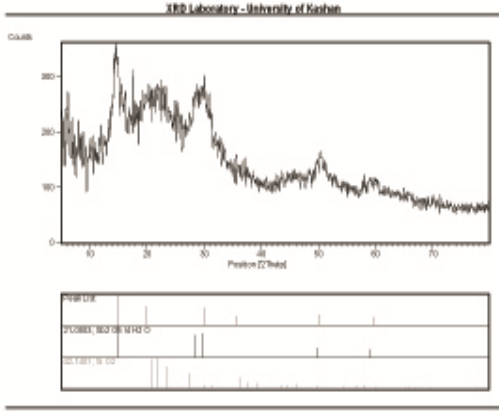
Fig. 2. The XRD pattern of nano SbCl /SiO 5 2 To obtain a visual image of the nano- /SiO , scanning electron microscopy (SEM) SbCl 5 2 and transmission electron microscopy (TEM) were carried out. By SEM and TEM images some information about the morphology of the catalyst particles was obtained as presented in Figure 3. As can be seen from the figure, the sample shows a nano crystalline